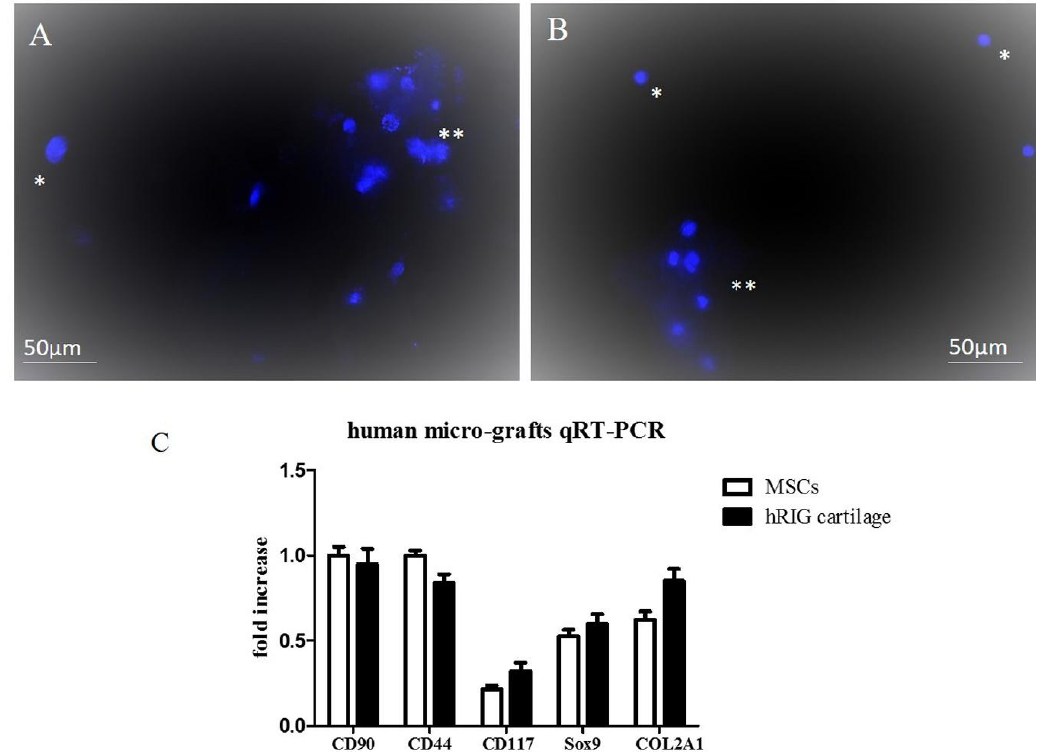
Figure 2. ( A , B ): Hoechst 33342 staining on micro-grafts suspension obtained from human auricular cartilage. (*) represents single nuclei cells, while (**) represents clusters of micro-grafts containing small groups of living cells. Magnification at 20×. ( C ): Gene expression analysis of the indicated specific markers as determined by qRT-PCR. qRT-PCR analyses were performed on human MSCs cultivated in proliferative medium for 7 days and on micro-grafts obtained from auricular cartilage. The graph shows the fold induction of gene expression expressed in arbitrary units. Statistical significance values are indicated as *: p < 0.05, **: p < 0.001.